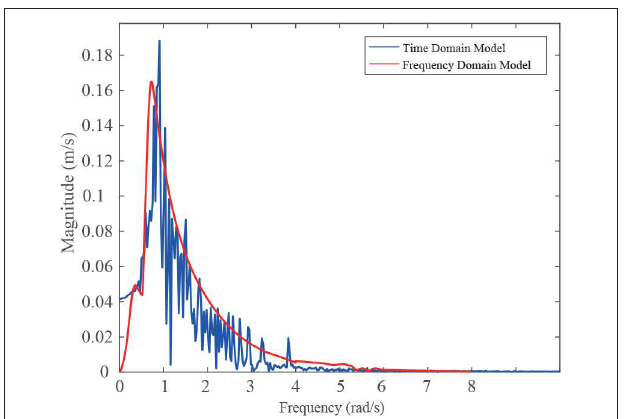
FIGURE 9 | Spectrum of the relative motion speed under the irregular wave